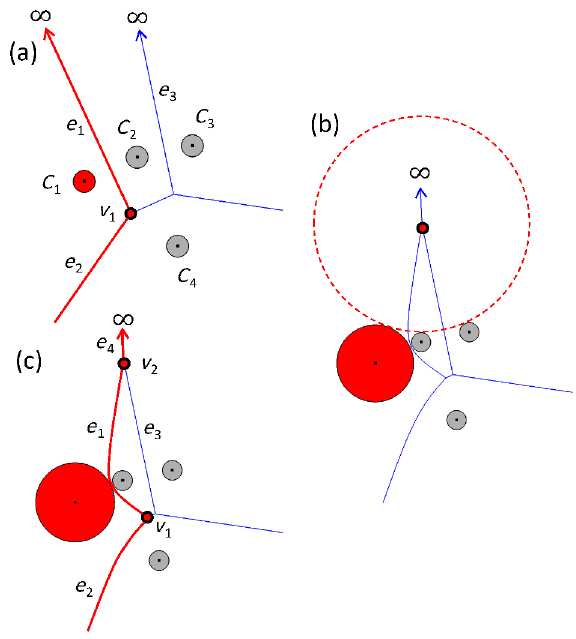
Fig. 12 An expanding unbounded Voronoi cell with infinite cell edges: (a) before expansion, (b) a newly generated circumcircle exists, (c) after expansion, with a new generated vertex v 2 and edge e 4 .